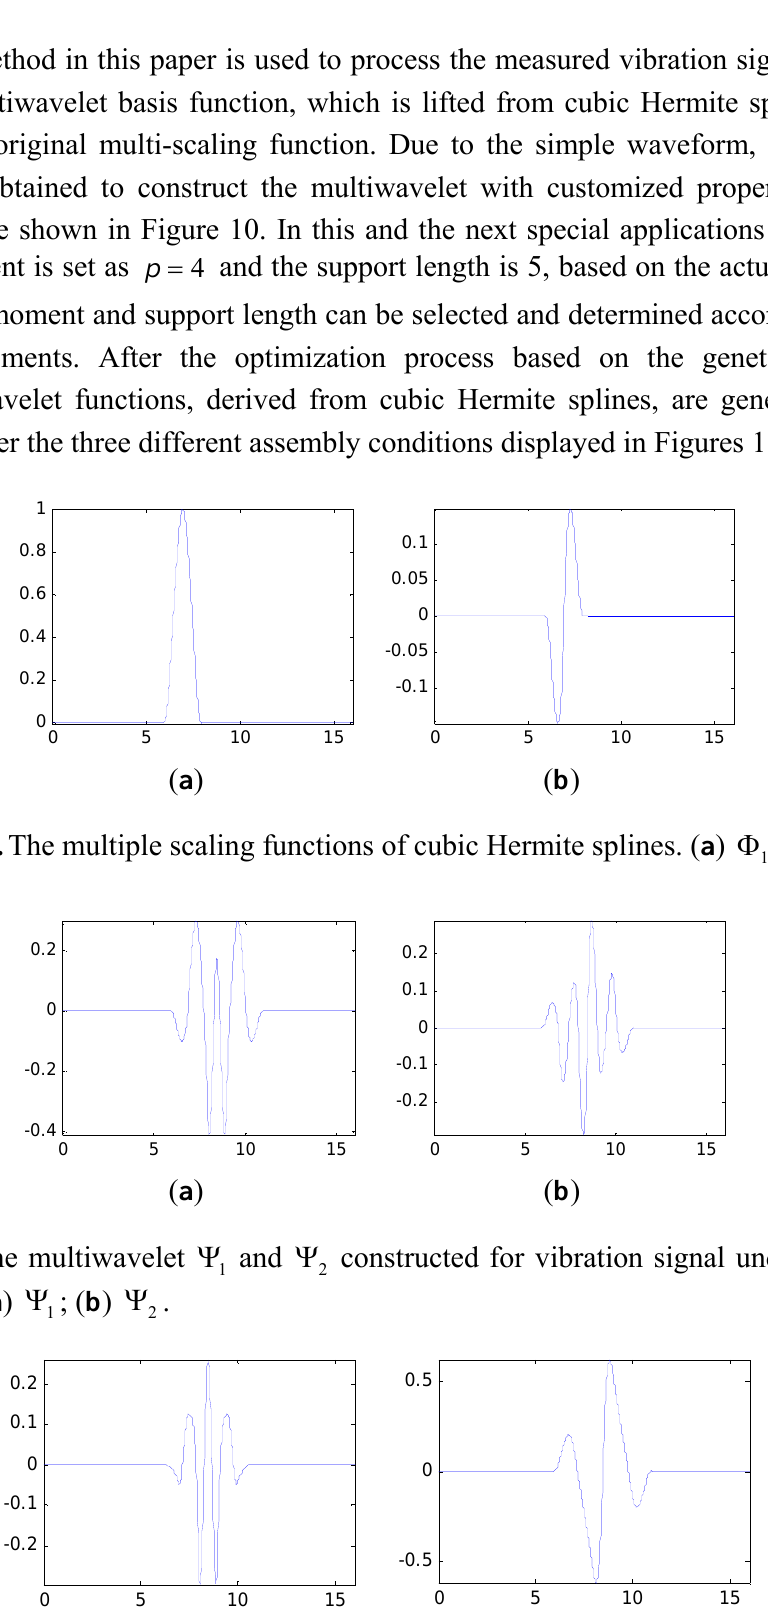
Figure 12. The multiwavelet condition 2. ( a )